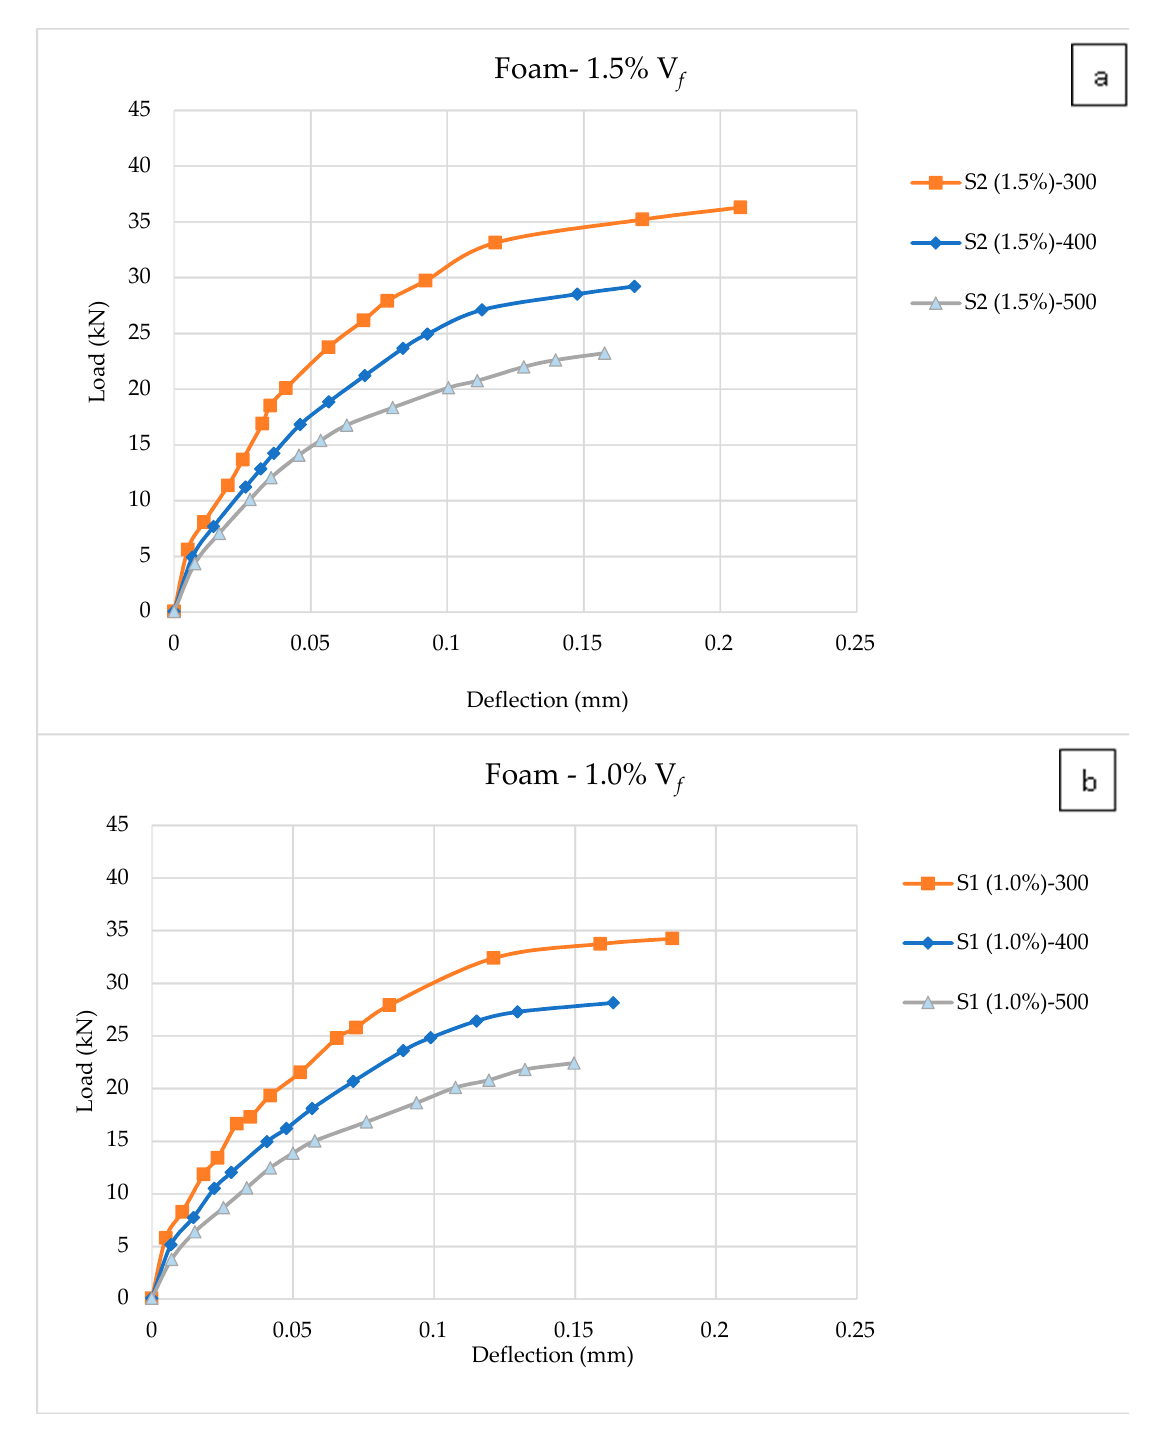
Figure 13. Load-Deflection curves concerning foam cooling at different burning temperatures: ( a ) For 1.5% V f ; and ( b ) For 1.0% V f .